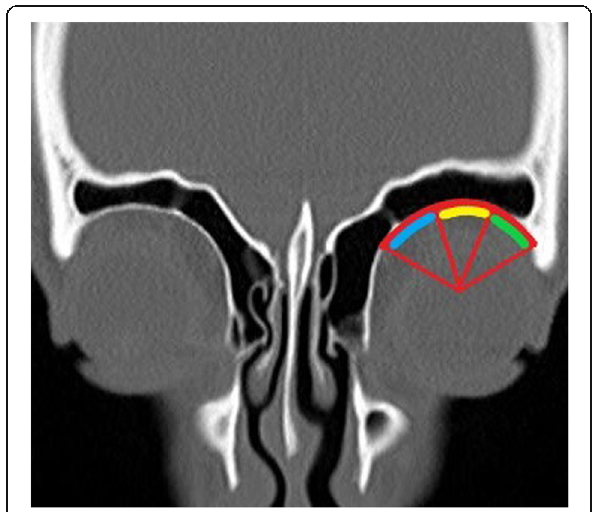
Fig. 1 Coronal computed tomography section demonstrating the division of the orbital roof in three equal parts. Medial, central, and lateral thirds of the roof are shown by blue, yellow, and green lines,